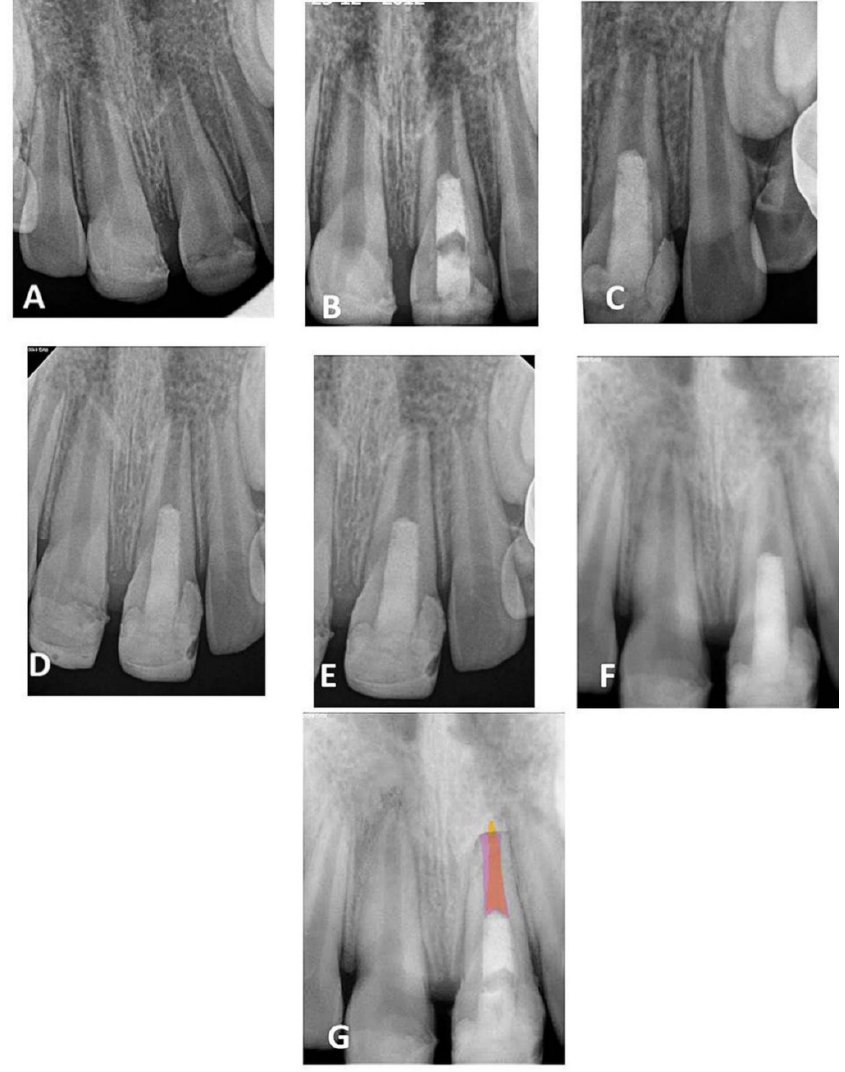
Figure 1. ( A ) Periapical radiograph of traumatized nonvital tooth #21 of a 9-year-old with wide-open apex; ( B ) immediate post-treatment radiograph showed MTA plug in the coronal third and composite restoration; ( C – F ) follow-up images after 6, 12, 24, and 36 months, respectively, showed consequence reduction in apical canal width, thickening of the radicular dentin wall, and increase root length; ( G ) overlapped periapical radiographs of immediate post-treatment and at 36 months of follow-up showed an increase in the root lengthen and apical closure after 36